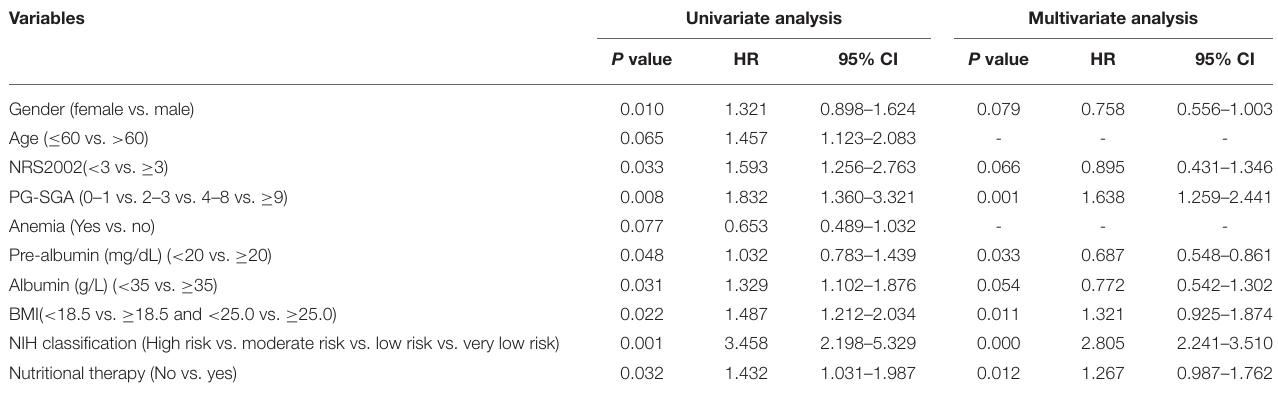
TABLE 6 | Univariate and multivariate analyses for OS in patients with newly diagnosed GIST. Variables Univariate analysis Multivariate analysis P